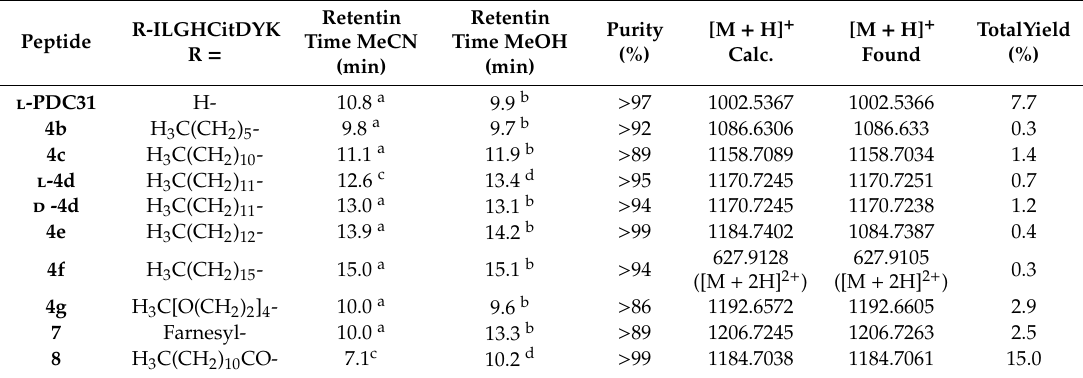
Table 1. Retention time, purity, exact mass and overall yield of peptides 4b–4g , 7 and 8.